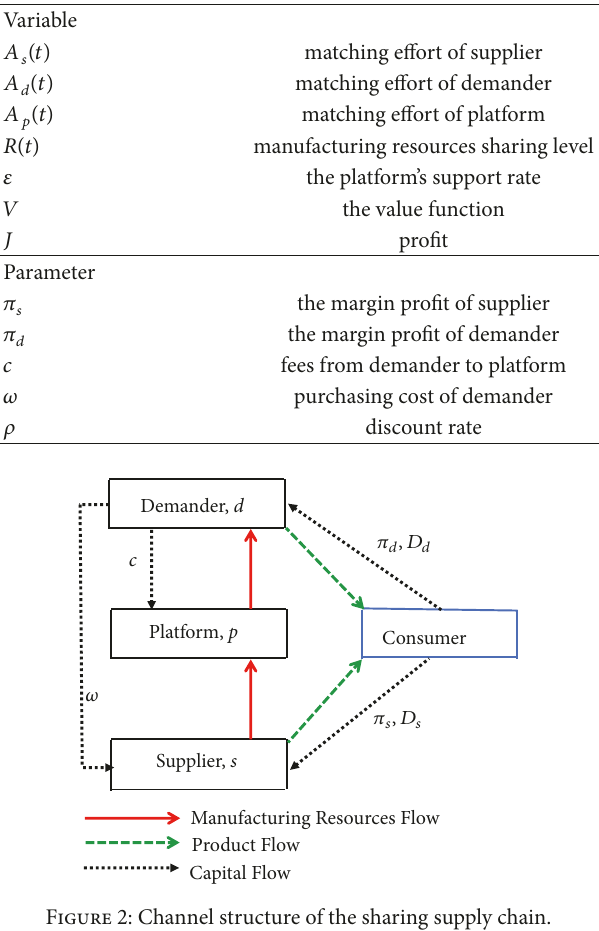
Table 1: Notation and descriptions.